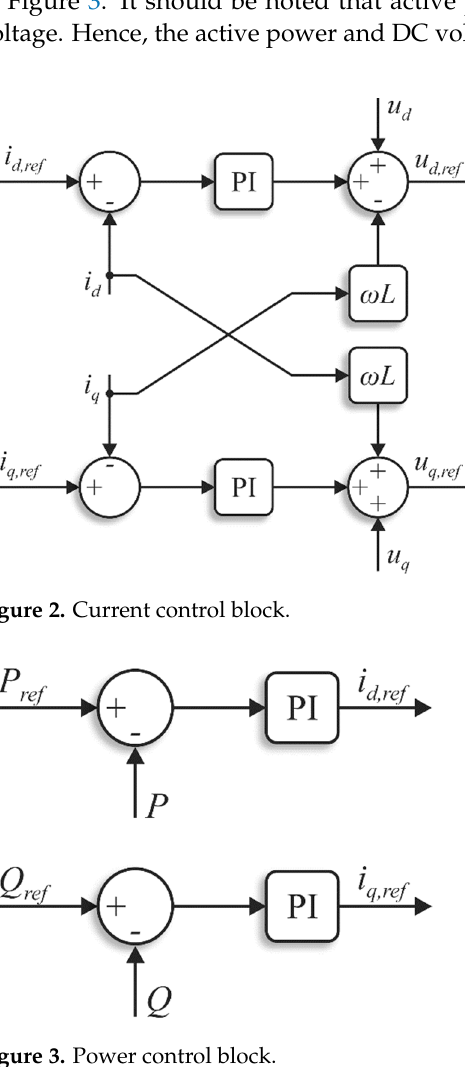
Figure 3. Power control block.